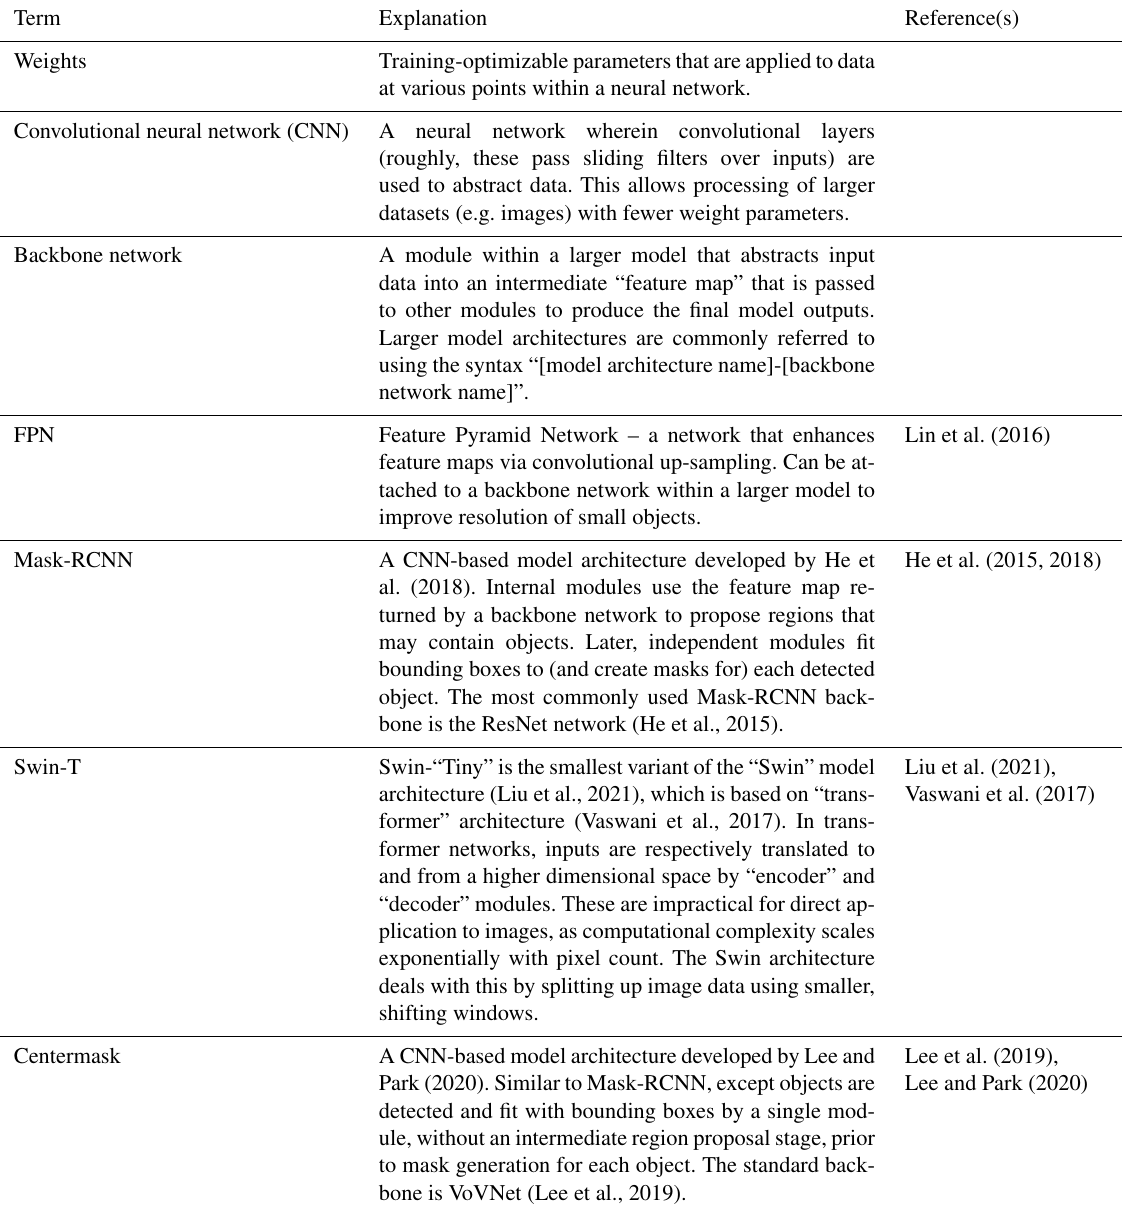
Table B1. A glossary of deep learning terminology used in this